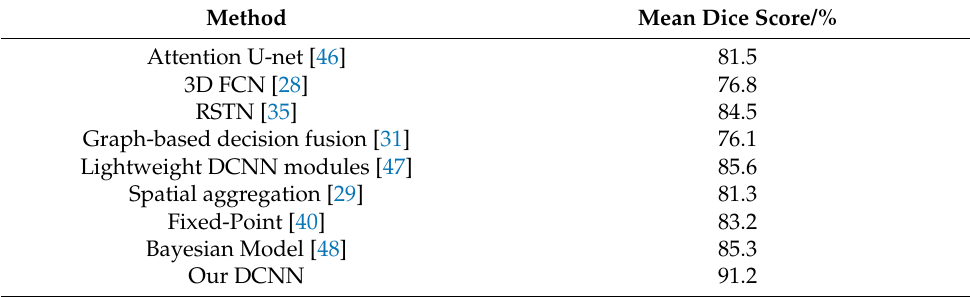
Table 2. Mean DSC values of recent frameworks for pancreatic segmentation.